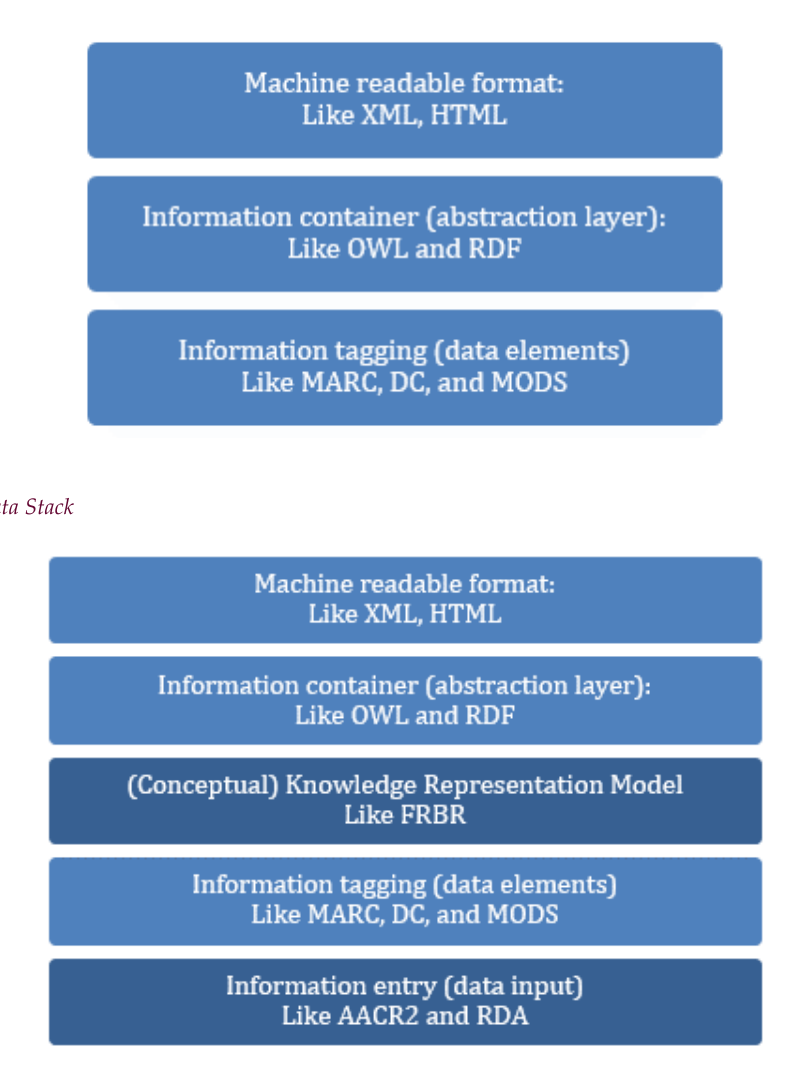
Linked Data Stack, Conceptual Information for Information Retrieval and Librarian Use